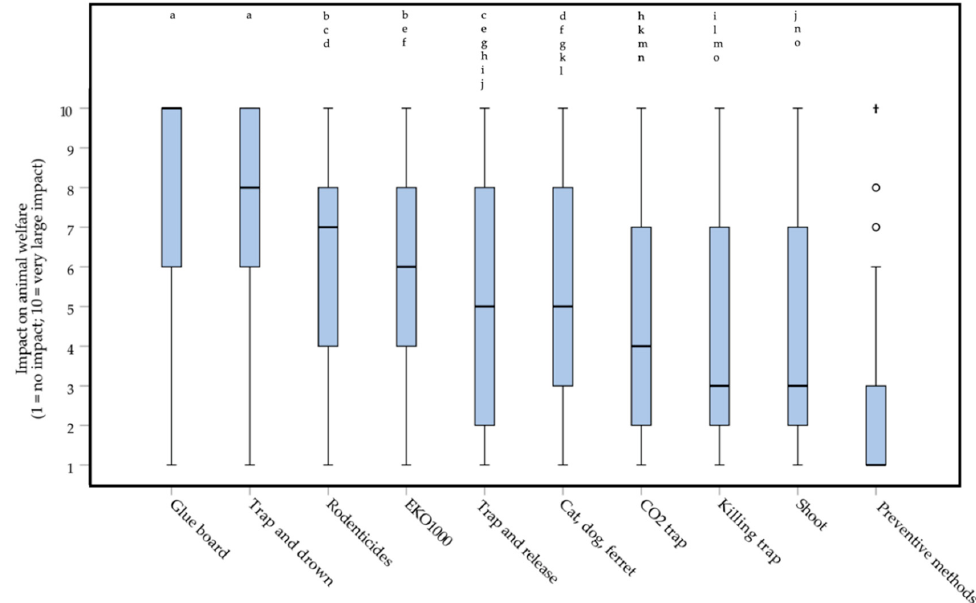
Figure 5. Box plots presenting the welfare impact of ten methods for the control of rats ( Rattus rattus and Rattus norvegicus ) and mice ( Mus musculus ), according to 129 Dutch pest controllers participating in an online survey. The impact could be indicated on a 1 (no impact) to 10 (very large impact) interval rating scale. Outliers and extreme cases are indicated with o and †, respectively. Di ff erences between the two methods that are not statistically significant are indicated with letters above the bars.